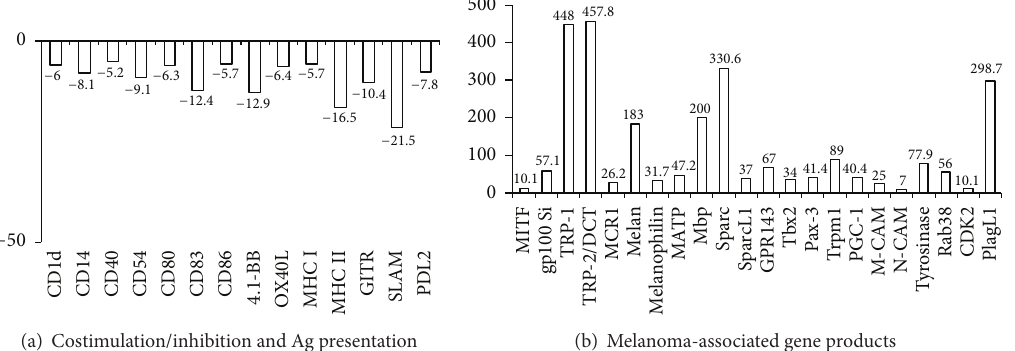
Figure 3: Expression level of costimulatory molecules and molecules involved in antigen (Ag) presentation (a) or melanoma-associated gene products (b) in DC-tumor cell hybrids. Microarray data for DC-tumor cell hybrids and DCs were compared. Positive values indicate upregulation in DC-tumor cell hybrids. Data from different probe sets were obtained for CD1d, HLA-class II (HLA-Q6 and HLA-Q7), MITF, Melanophilin, Pax3, PGC-1, MATF, SPARC, Mbp, Tyrosinase, Trp1, and Trp2. For these gene products the average in gene expression is